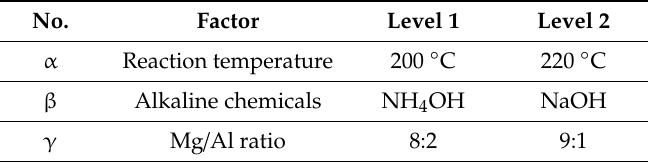
Table 3. Three factors and levels of hydrothermally synthesized smectites in the external orthogonal array. No. Factor Level 1 Level 2 α Reaction